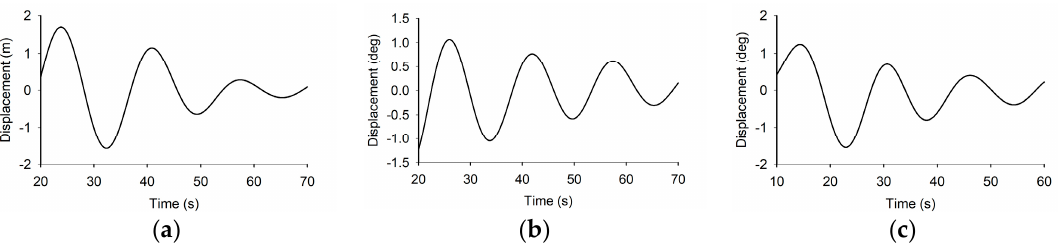
Figure 6. Platform free decay test results: ( a ) Heave; ( b ) Roll; ( c ) Pitch. Table 3. Natural frequencies.